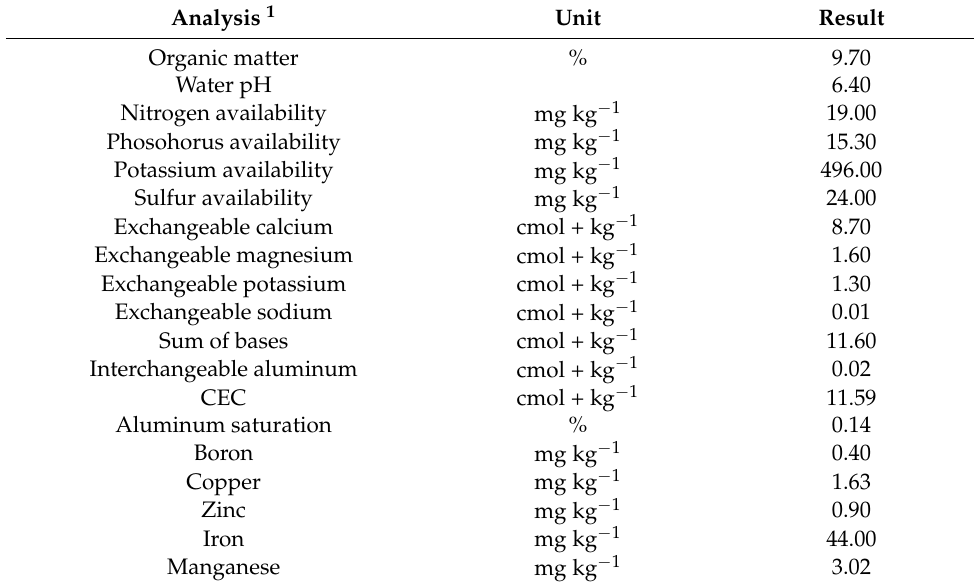
Table 1. Physical-chemical analysis of the soil before